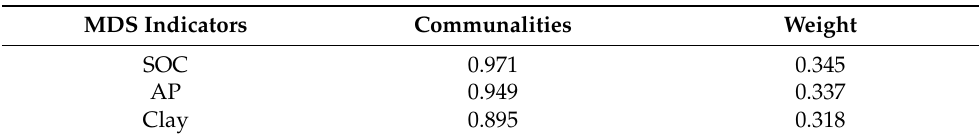
Table 5. Estimated communalities and weight of the soil indicators selected as the minimum data set (MDS).